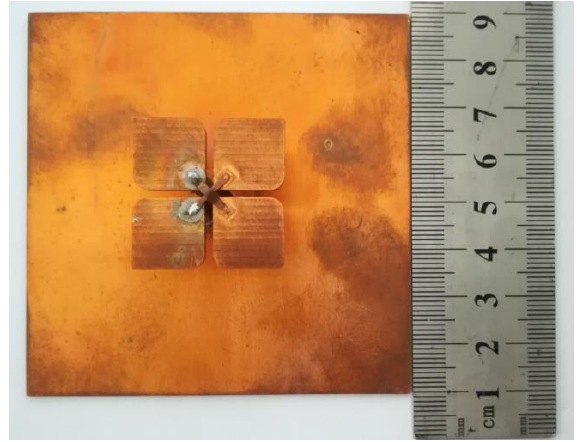
Figure 4. Photo of the proposed antenna prototype.